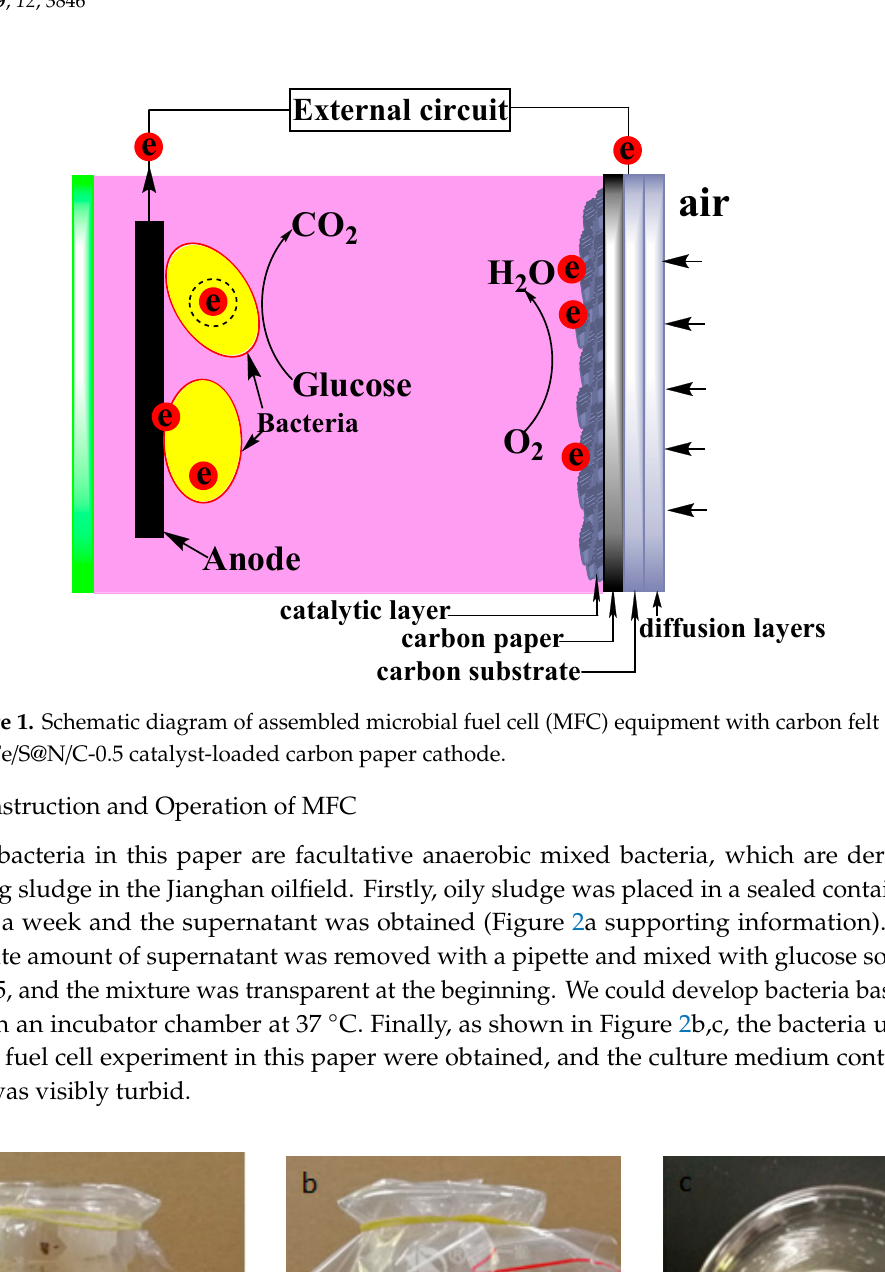
5 Table 3. Formulation of trace mineral element solution.